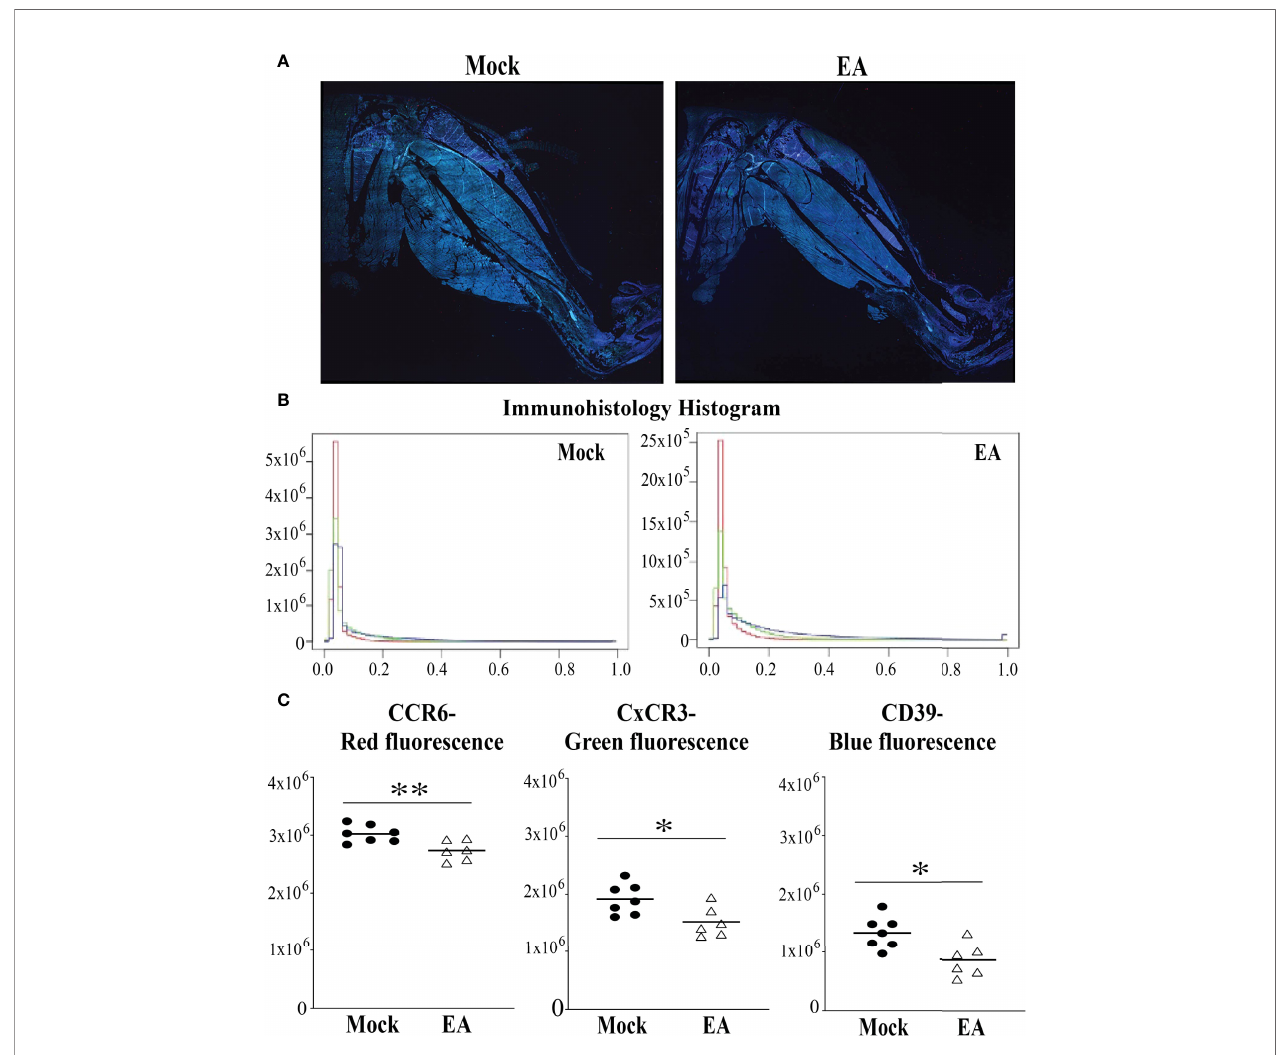
FIGURE 3 | Fluorescence immunohistopathological examination of male mice joints to determine the effect of EA on CD4+ Th17 (CCR6 staining), Th1 (CxCR3 staining), and Tregs (CD39 staining) in fi ltration. (A – C) Both Th1 and Th17 cell in fi ltration diminished in whole joint after EA treatment signi fi cantly. Treg levels in EA- treated mice appear to be suf fi cient, albeit reduced, to counterbalance the effect of Th17 and Th1 in causing in fl ammatory Lyme arthritis. All three fl uorescence signal pixels were counted using the microscope and are presented here (B,C). Statistical analysis was conducted using two-tailed unpaired Student ’ s t-tests for unequal variance to determine signi fi cant differences between the paired groups (NS, not signi fi cant; *p < 0.05, **p < 0.01). EA,